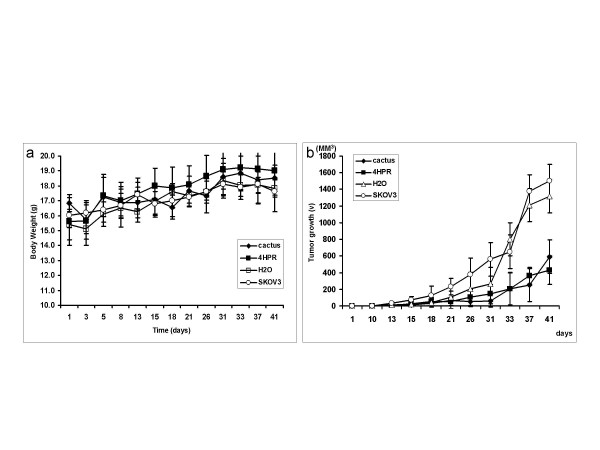
a. Animal body weight curve. The body weight was measured twice a week during the experiment. The picture represents the control animal labeled as H2O and treated-animal as SKOV3 only (SKOV3), SKOV3 + cactus pear (pear sol), and SKOV3 + 4HPR (4-HPR). b. Tumor growth curve. Tumor size in cactus pear and 4-HPR treatment groups, compared with control SKOV3 only and SKOV3 plus H2O, was significantly reduced (p < 0.05). The effect of cactus pear solution compared with 4-HPR on inhibiting tumor growth, both agents were able to inhibit SKOV3 inoculated tumor growth, the difference is not statistically significant (p > 0.05).